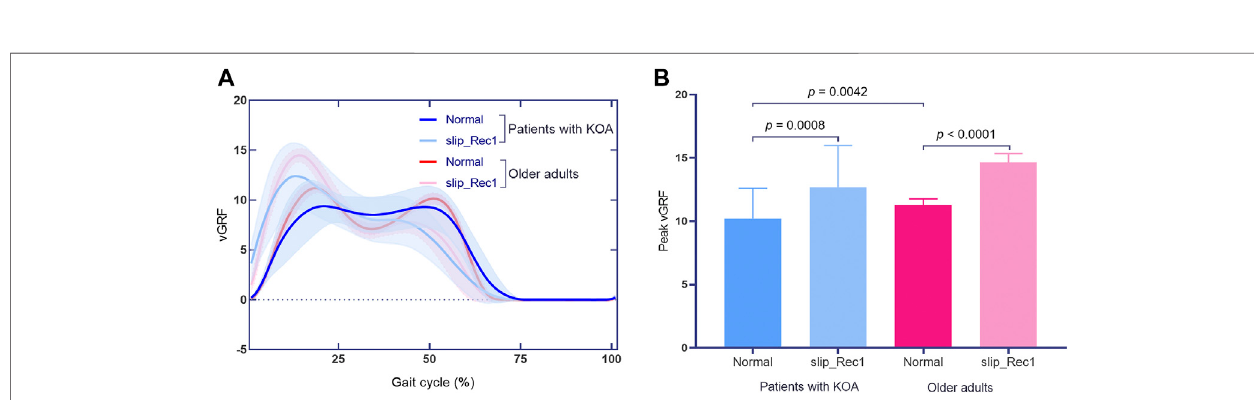
FIGURE4| Theverticalgroundreaction force(vGRF)curvesinNormalandslip_Rec1 (A) ;zero-dimensionalstatisticalanalysisofpeakvGRFsamongpatients with knee osteoarthritis (KOA) and older adults (B) .